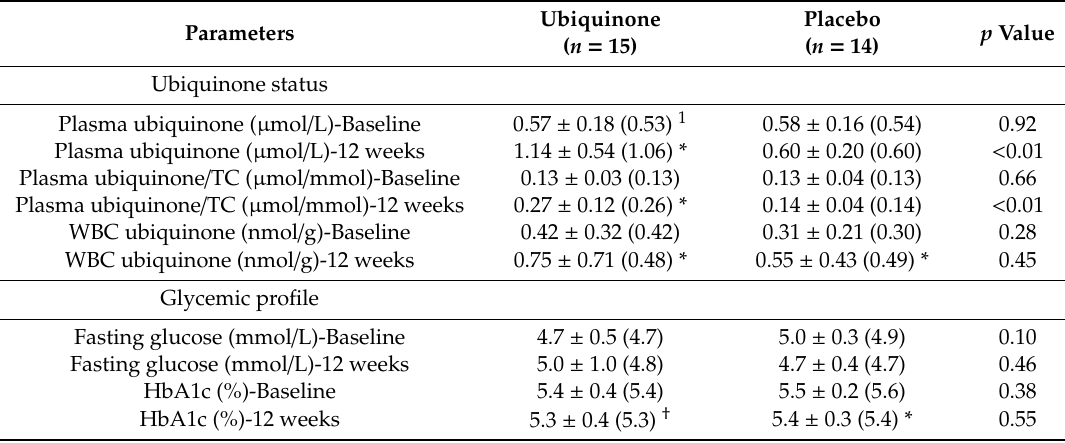
Table 2. Ubiquinone status, glycemic profile, oxidative stress, and total antioxidant capacity after